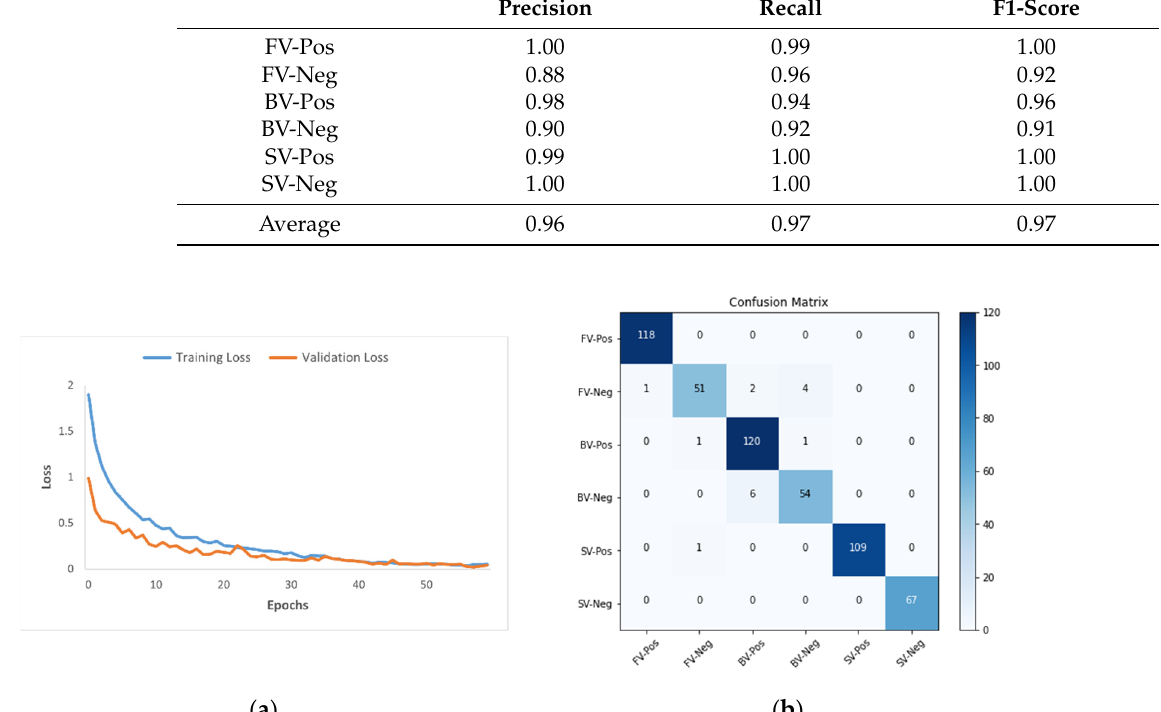
Table 12. Precision, recall, and F1-score for the first experiment on the PETA dataset.